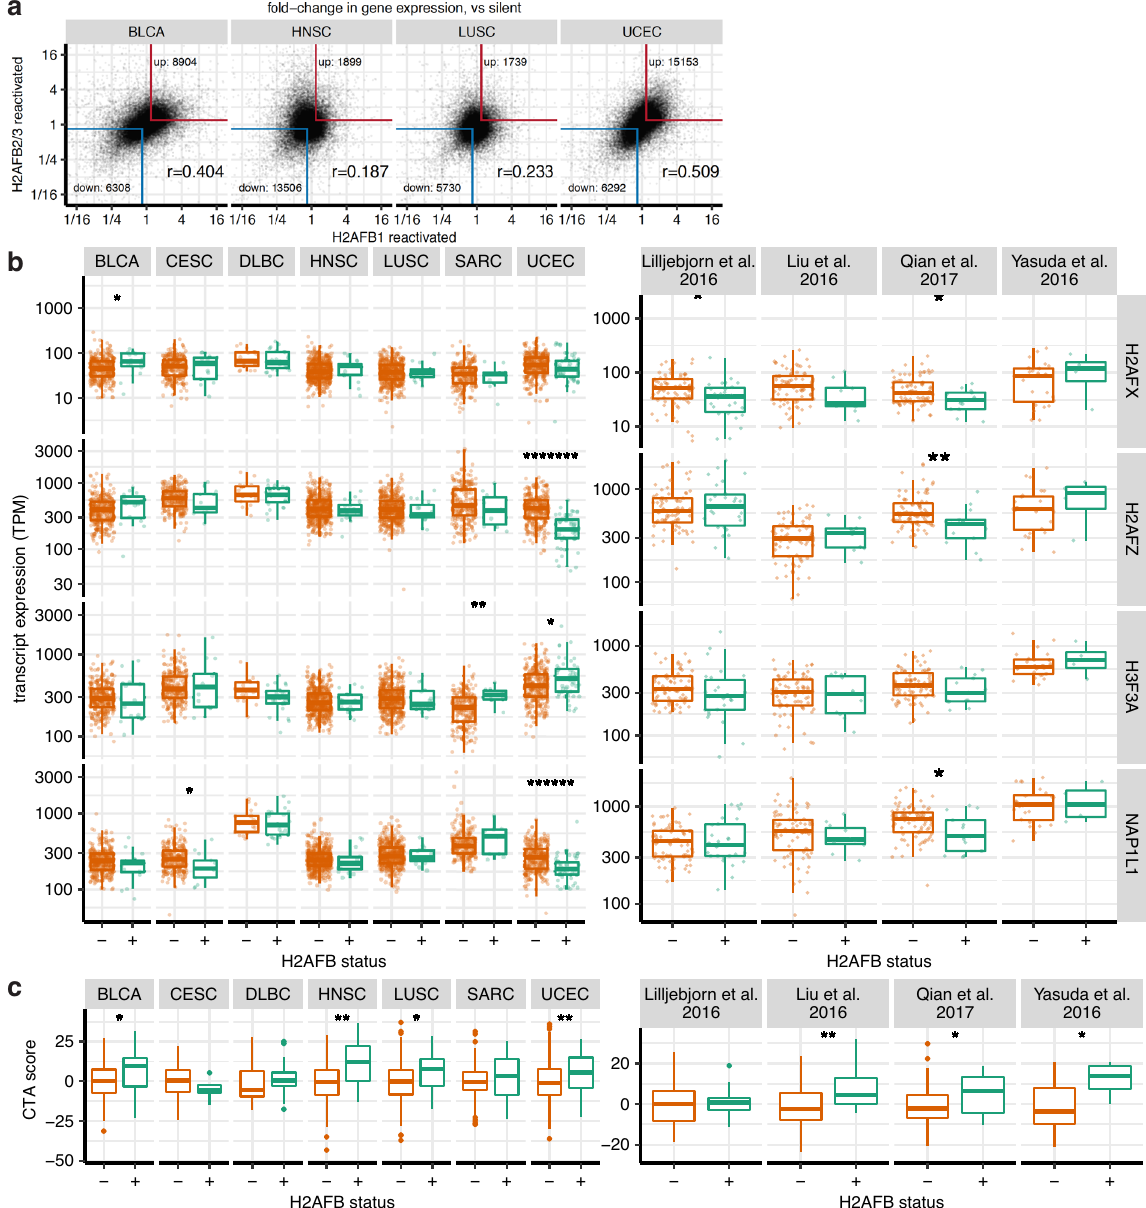
Fig. 3 Gene expression analyses in H2A.B-reactivated cancers. a Scatter plot of gene expression differences (expressed as fold-change), comparing H2AFB1 -positive against negative tumors ( x axes), and H2AFB2/3 -positive against negative tumors ( y axes). The red and blue borders show genes that are commonly up- or downregulated at >1.19-fold. Pearson correlation coef fi cient is also shown. b Boxplots comparing levels of H2A.Z ( H2AFZ ), H3.3 ( H3F3A ), H2A.X ( H2AFX ), and NAP1 ( NAP1L1 ) transcripts in H2A.B-positive (green) vs negative (orange) cancers from TCGA and B-ALL data sets. Asterisks show the statistical signi fi cance of the difference in TPMs by a two-sided Mann – Whitney U test. * p < 0.05; ** p < 0.01; ****** p < 0.000001; ******* p < 0.0000001. Number of cancer samples in each group are listed in Supplementary Table 2. Boxplots indicate the 1st quartile, median and 3rd quartile, whereas the whiskers extend from the box-ends to values no larger/smaller than 1.5 times of the inter-quartile range. All data points are additionally plotted. c Boxplots as in b , comparing CTAs scores in H2A.B-positive (green) and negative (orange) cancers in TCGA and B-ALL cancers. For each tumor, the expression of CTAs is summarized as a CTA score: the sum Z-normalized log expression of the top 40 most variably expressed CTAs (within each cancer type). Asterisks show the statistical signi fi cance of the difference in CTA scores by a one-sided Mann – Whitney U test. * p < 0.05; ** p < 0.01. Outlier points beyond the whiskers are additionally H2A.B-expressing cancers have distinct splicing patterns . H2A. of H2A.B-reactivated and silent tumors from the TCGA data set. B has been shown to directly bind RNA and interacts with spli- cing factors and H2A.B expression impacts alternative splicing patterns 17 – 20,22 . To determine if H2A.B expression is associated with splicing dysregulation, we annotated and quanti fi ed all constitutive and alternative splicing events in the transcriptomes